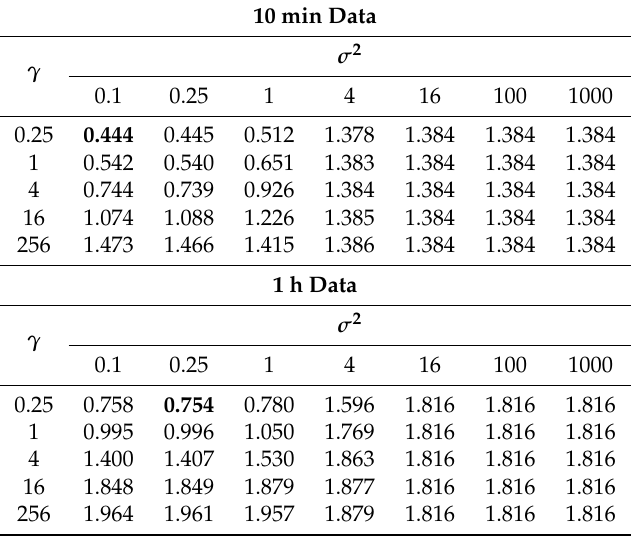
Table 4. Single SVM model selection for wind speed time series at the GD site, mean absolute error (MAE).